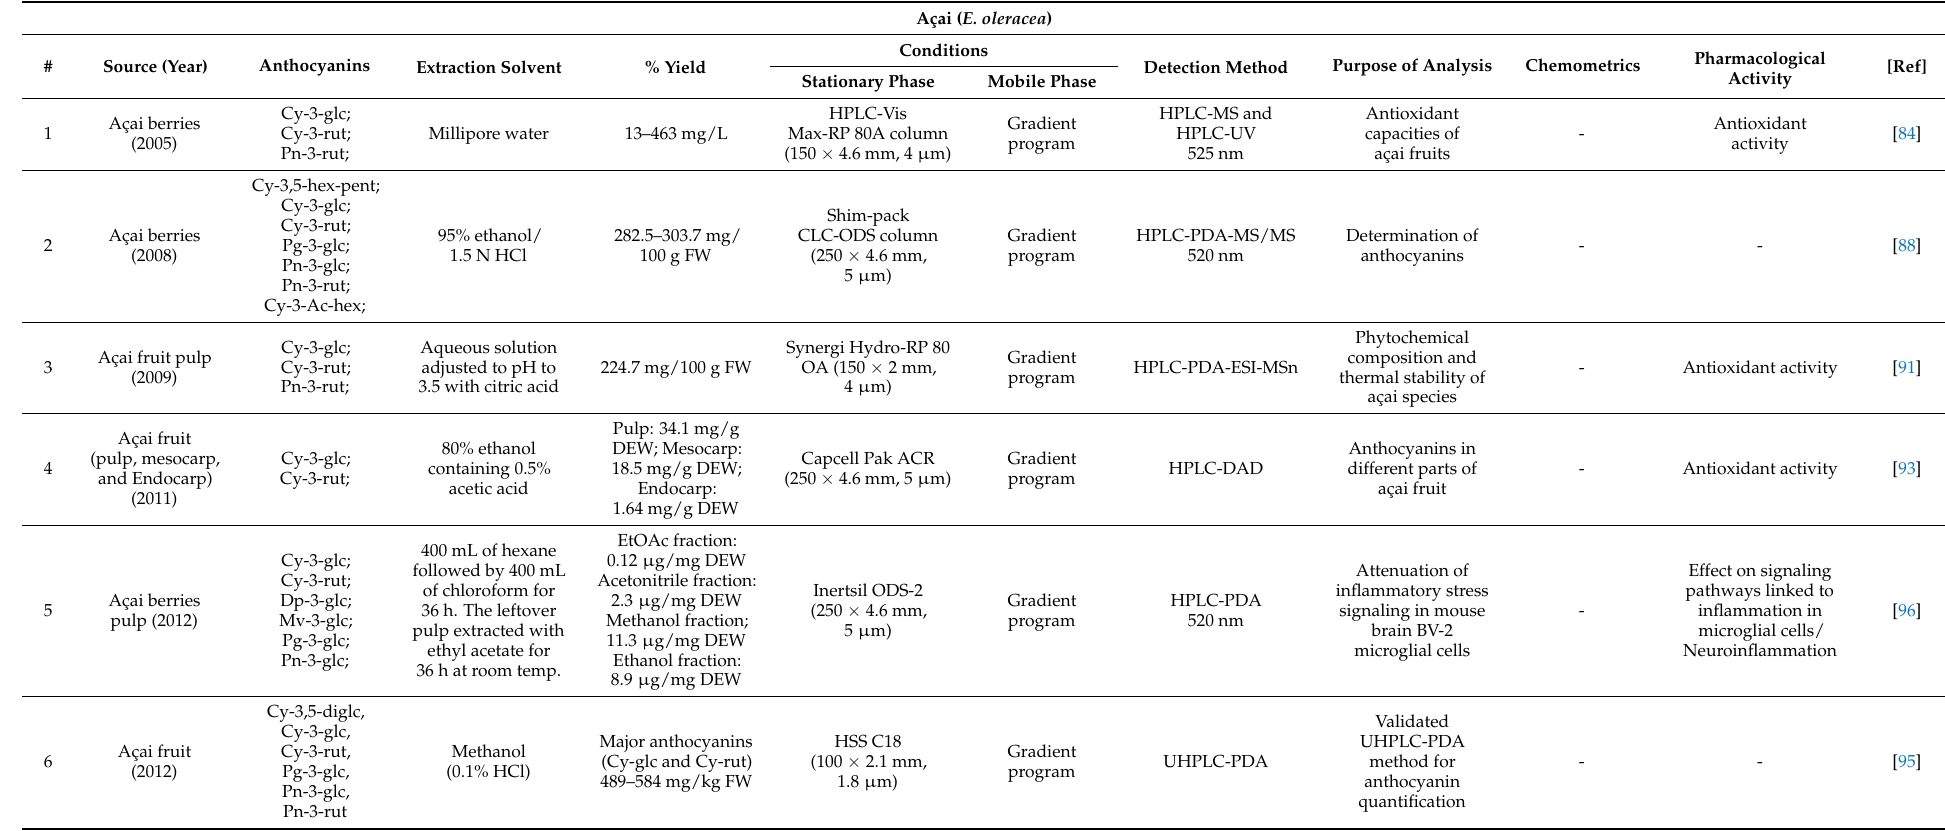
Table 4. Distribution, extraction method, % yield, detection methods, analysis purpose and references of anthocyanins in selected fruits and